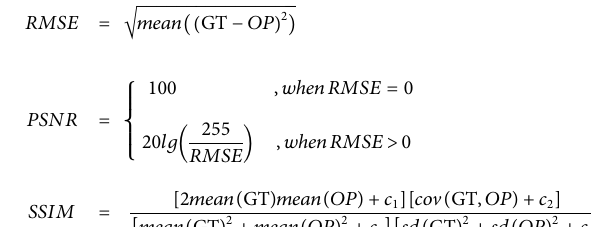
Frontiers in Chemistry |